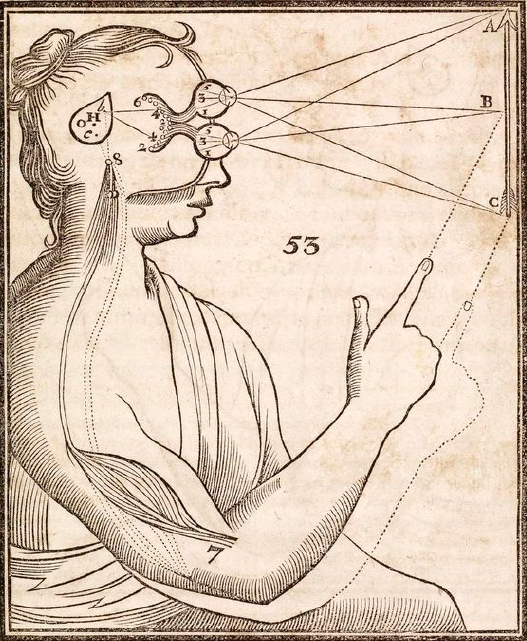
Figure 1. Descartes’ 1644 illustration from Principles of Philosophy [1] showing his theory of vision. Light rays from the arrow stimulus (A,B,C) impress particles into the eyes from which the image is transmitted to the pineal gland, the confluence of mind and body. It is as if the visual system is an internal screen or theatre [2]. The picture shows the pineal gland converting an external stimulus into the action of